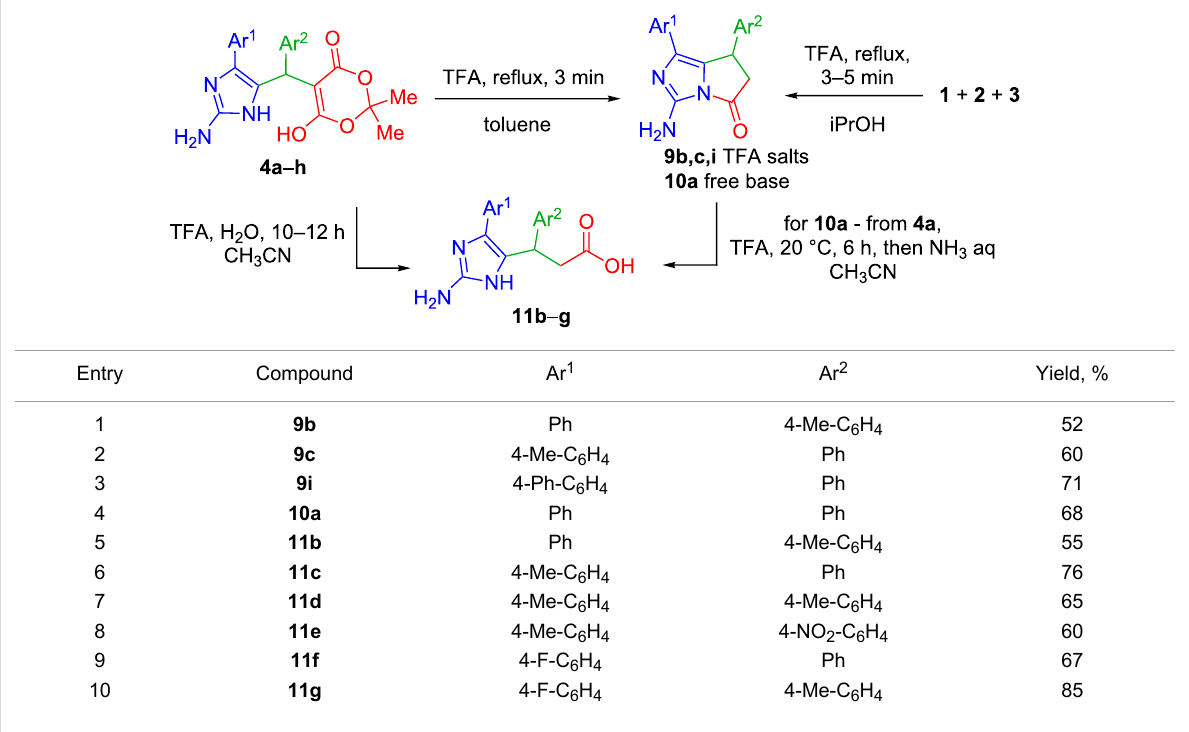
Single crystal X-ray diffraction analysis of biphenyl